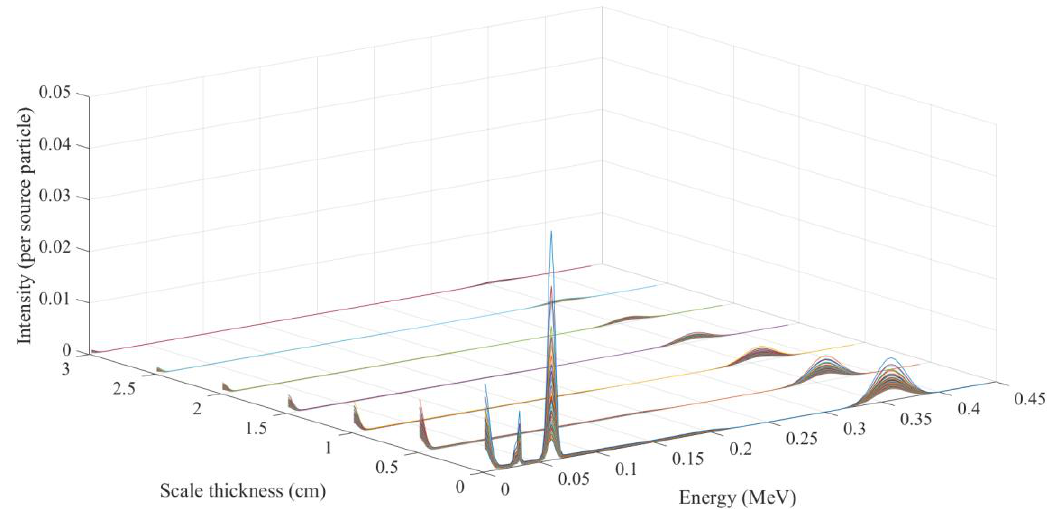
Figure 2. Signals recorded by the sodium iodide detector